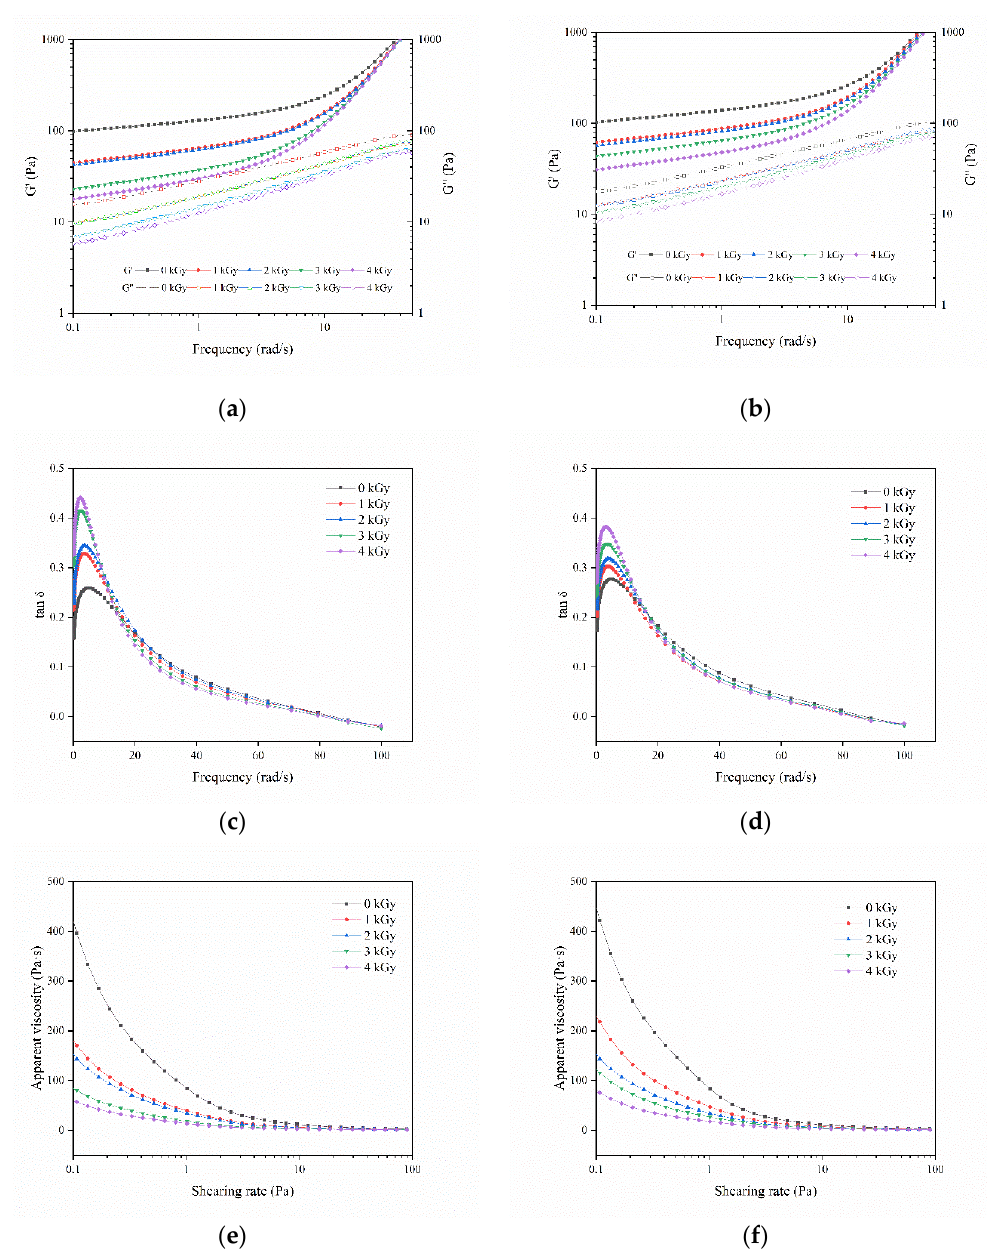
Figure 4. Changes in G′, G″ ( a , b ), tan δ ( c , d ), and apparent viscosity ( e , f ) of RSs under different electron beam irradiation (EBI) doses. ( a , c , e ) LM rice; ( b , d , f ) HM rice.